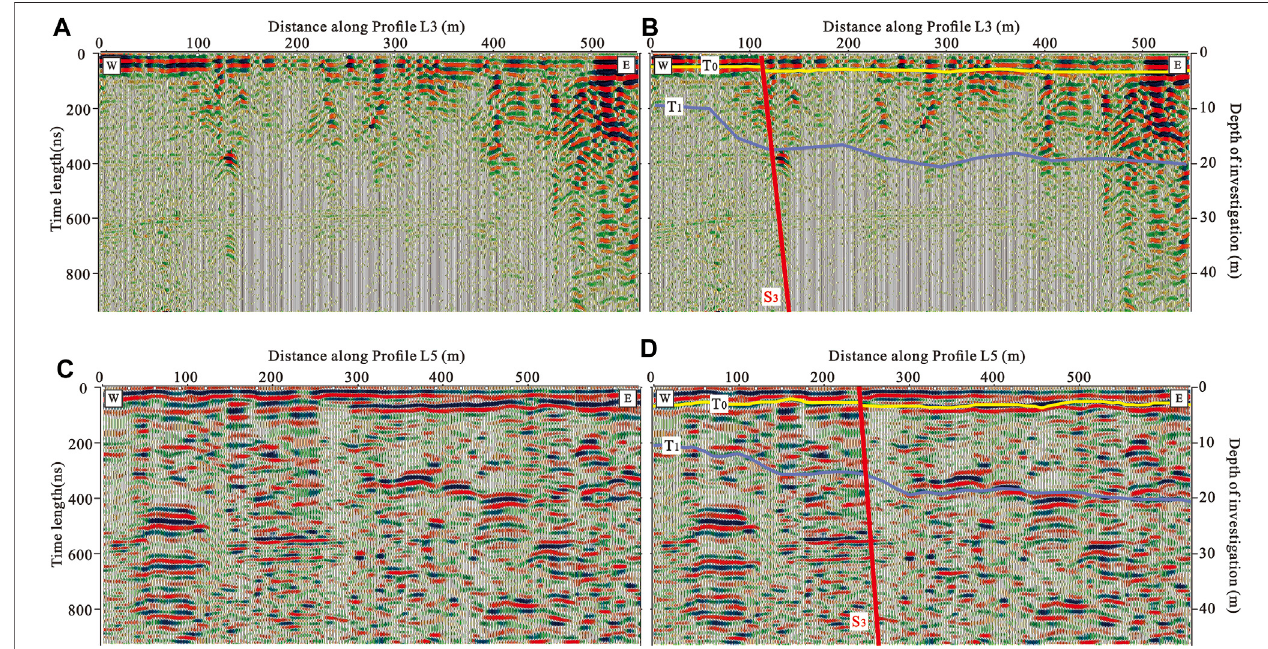
FIGURE 7 | GPR sections on the line extending from the northern end of S 2 . (A,B) : Section L3 of GPR; (C,D) : Section L5 of GPR; T 0 : The bottom of the Holocene deposits; T 1 : The bottom of the Quaternary sedimentary deposits. The locations of the two test lines are shown in Figure 5C .